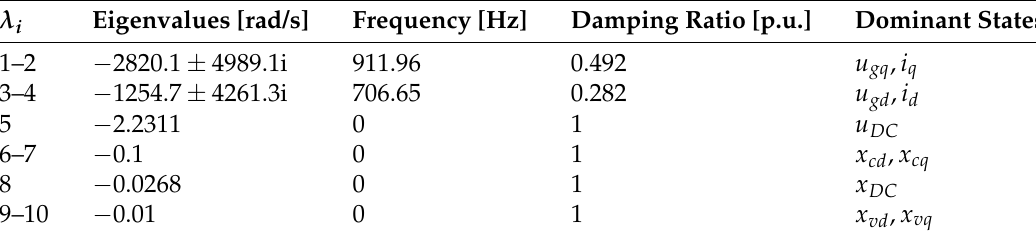
Table 4. Base-case eigenvalue